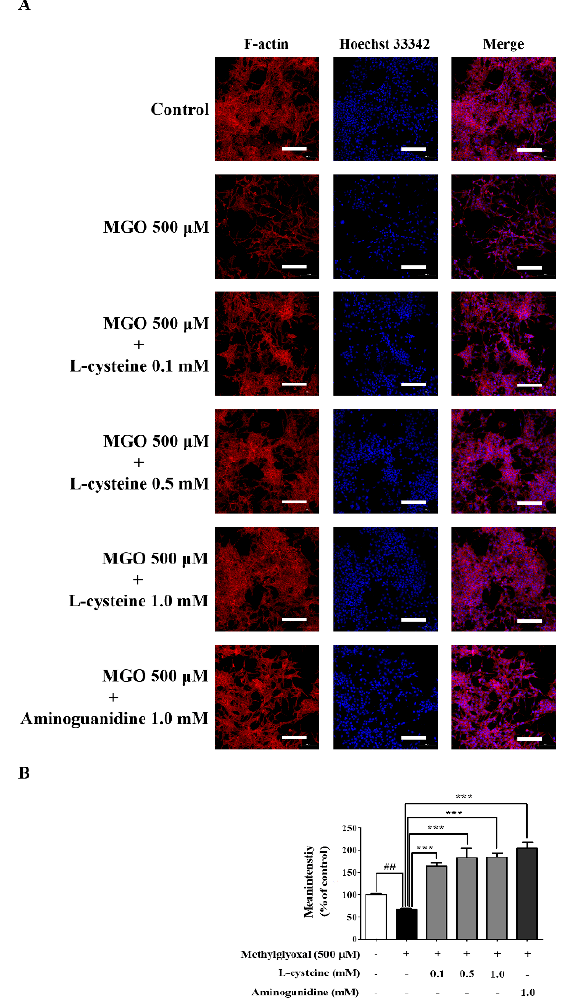
Figure 7. E ff ects of l -cysteine on MGO-induced cytoskeletal proteins in MES13 cells. ( A ) MES13 cells were pretreated with l -cysteine for 1 h, followed by 500 µ M MGO for 1 h. The cells were stained with Hoechst 33342 (blue) and F-actin (Red) Alexa Fluor 555 ® Phalloidin, and observed using confocal microscopy. The blue color indicated DAPI (nuclear) staining. Scale bar indicates 100 µ m. ( B ) Quantitative measurements of F-actin fluorescence intensity were evaluated using NIS-Elements imaging software. Scale bar indicates 10 µ m. All data are presented as mean ± SEM. n = 3 ( ## p < 0.01 vs. Control, *** p < 0.001 vs. MGO 500 µ M).